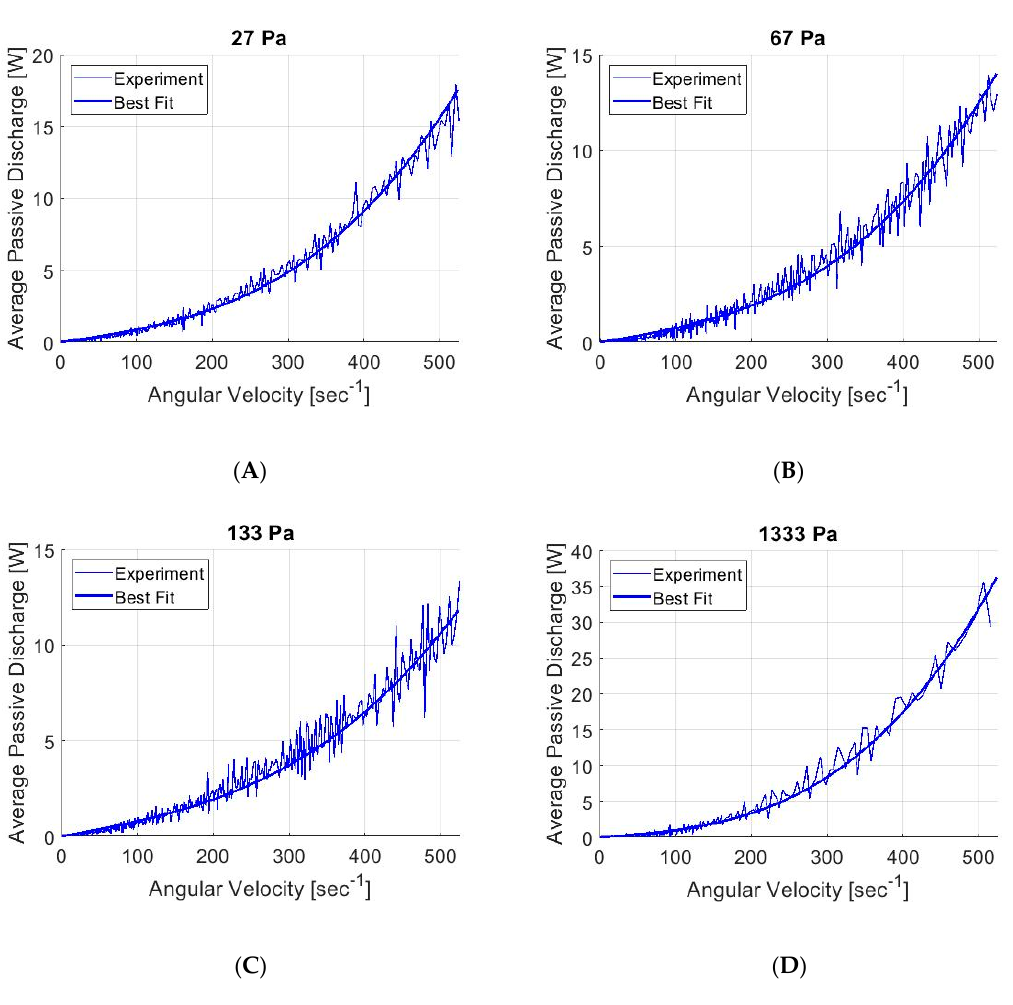
Figure 3. Average passive discharge and best-fit approximations for the four tested vacuum levels: ( A ) minimum, ( B ) low, ( C ) intermediate, and ( D ) high-pressure. Appl. Mech. 2020 , 1 , FOR PEER REVIEW